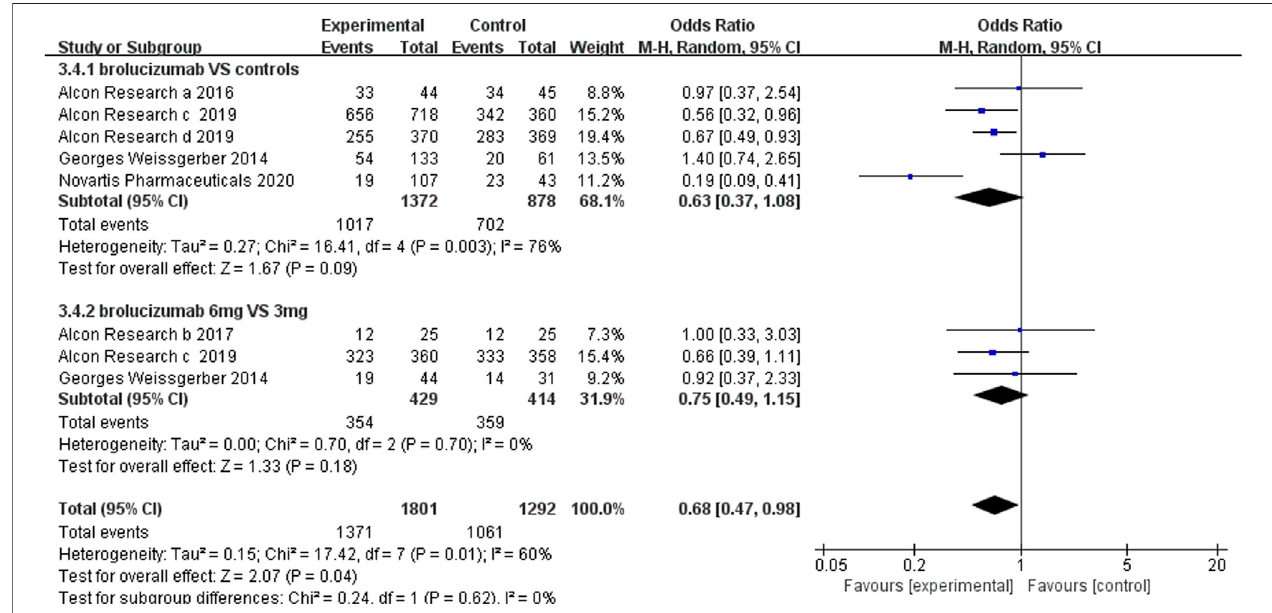
FIGURE 5 | Forest plots of the adverse events.